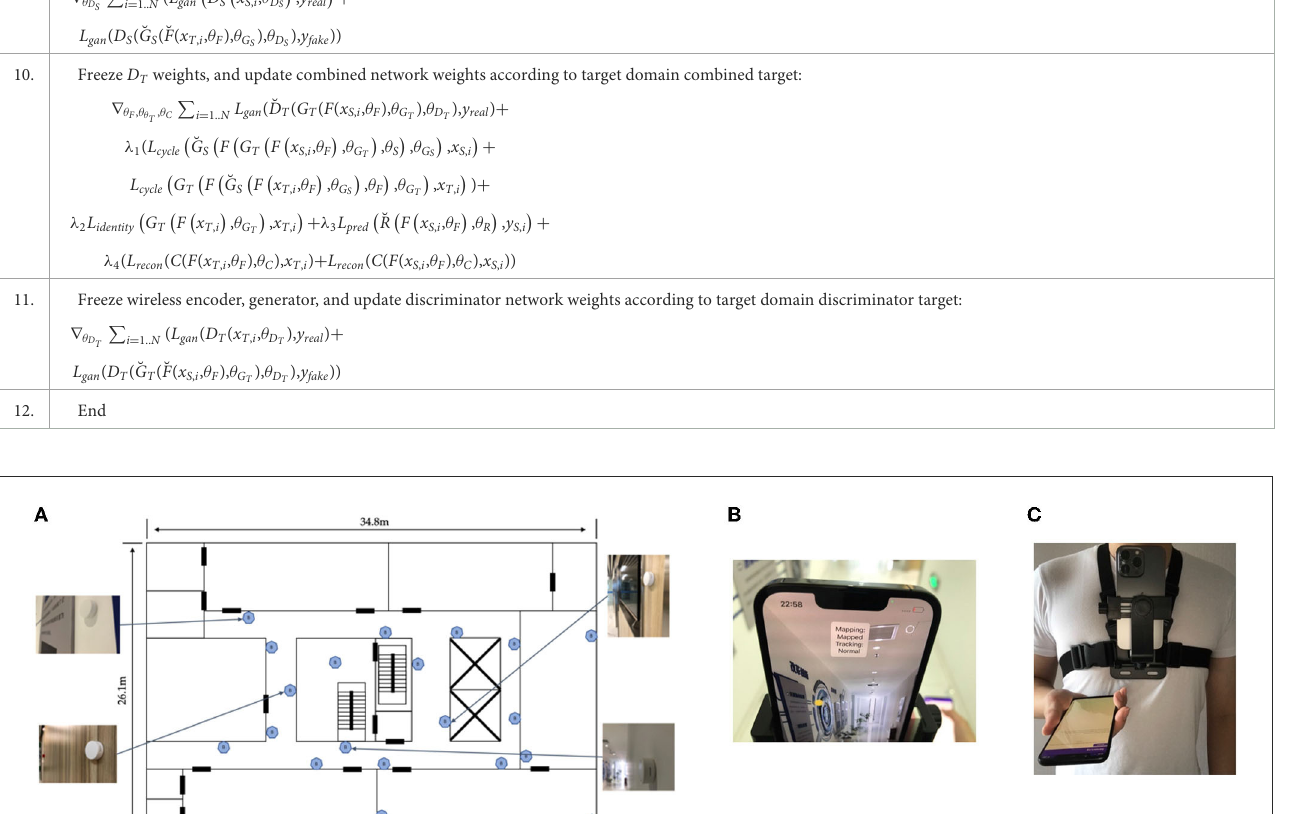
20 Hz. To verify the positioning accuracy of the system, we selected a rectangular trajectory as a reference according to the texture of the floor tiles in the experimental scene and carried out multiple continuous collections of 1-h slam, walking freely throughout the